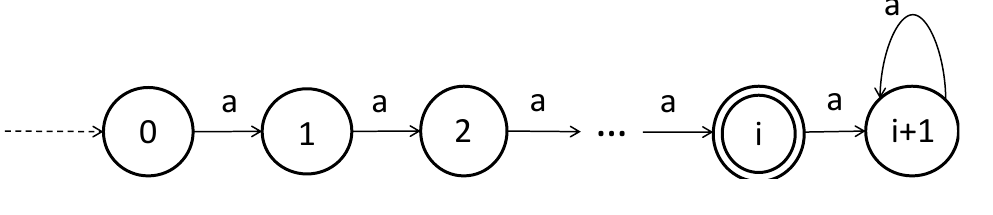
= { a i } , accepting state is i i